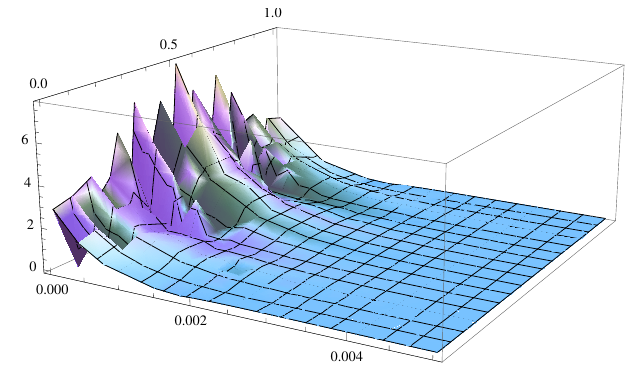
The synchronization dispersion D ( t ) is represented on Figure 7, where two cases are compared: the red line represents 10 11 ∗ D k =0 ,(cid:96) =0 ( t ) (i.e. the case of so- lution to Kuramoto system), while the blue one represents the case D k =5 ,(cid:96) =6 ( t ) . It is clear that in the high frequency case the synchronization dispersion is much stronger than for the case of pure Kuramoto